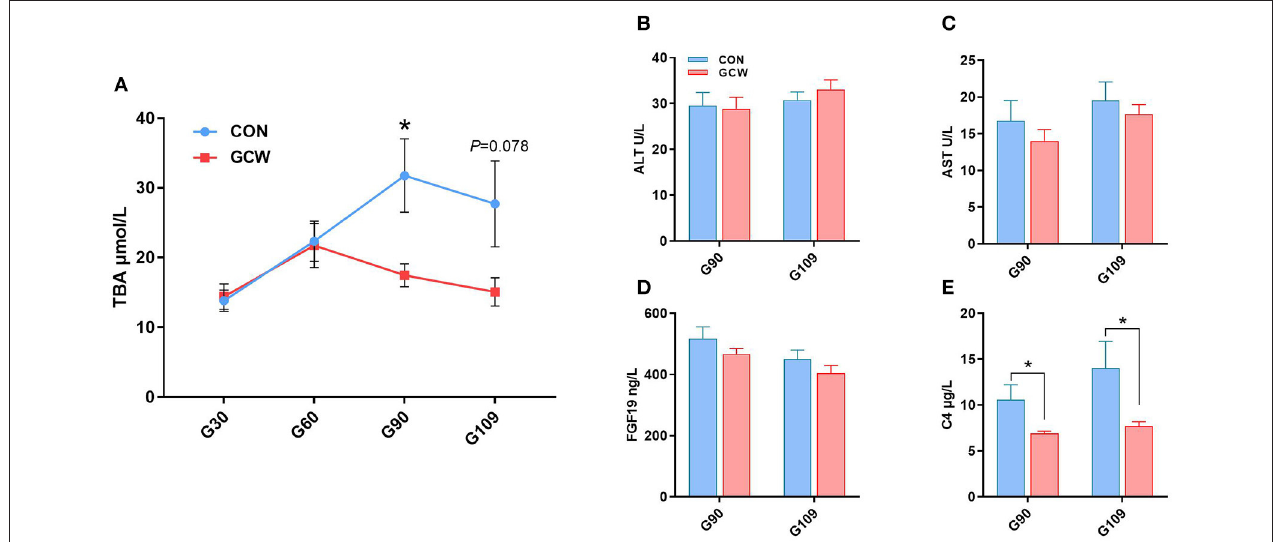
FIGURE 3 | (A) Dynamic change of maternal peripheral plasma TBA between the two groups across gestation ( n = 7–10/group). Plasma concentrations of ALT (B) , AST (C) , FGF19 (D) , and C4 (E) between the two groups during late gestation ( n = 8–10/group). Data are presented as means ± SEM. * p <